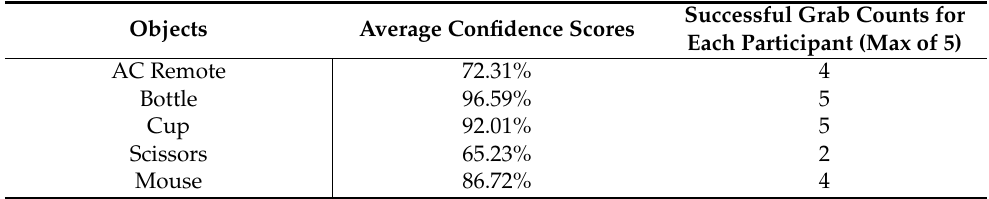
Table 5. Object detection evaluation with average confidence score and successful grab counts for each